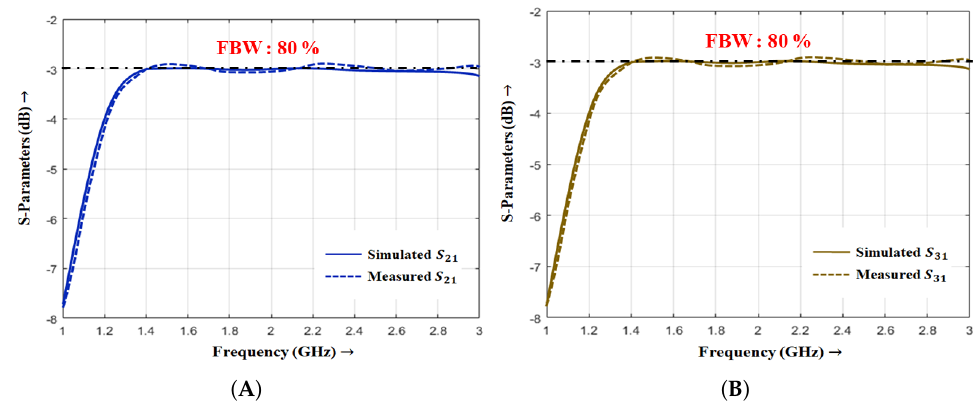
Figure 14. EM vs. Measured S-parameters for ( A ) S 21 ; ( B ) S 31 for θ c = 55 ◦ . The measured return loss S 11 (dB) and isolation S 23 (dB) is better than − 10 dB and − 12 dB, respectively, within the frequency range of 1.0–3.0 GHz. The measured insertion losses at output ports, S 21 (dB) and S 31 (dB) are − 3.0 ± 0.4 dB which are comparable to the simulated results of − 3 dB.